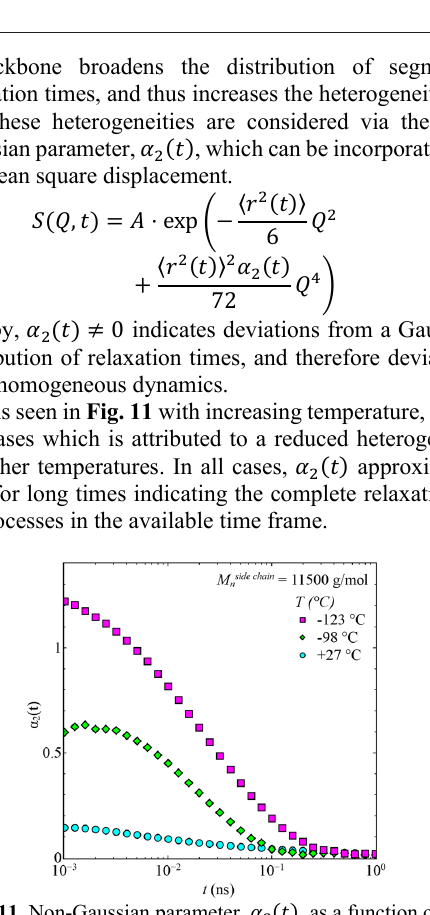
Fig. 11. Non-Gaussian parameter, 𝛼 (cid:2870) (cid:4666)𝑡(cid:4667) , as a function of time, 𝑡 , for Sample 3 at selected temperatures. Data has